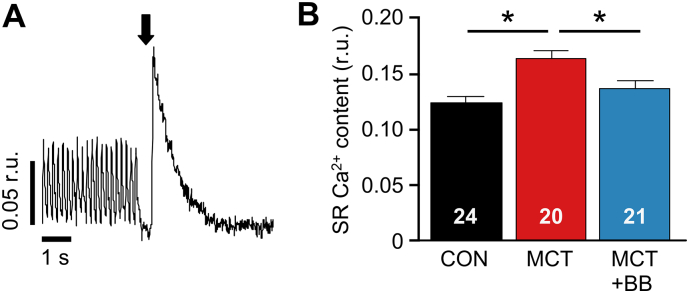
Increased SR load in MCT cells is reversed by BB. A SR Ca2+ content was estimated during steady state pacing at 5 Hz by rapid application of caffeine (indicated by arrow) to deplete SR stores. B SR load was increased in MCT compared to CON, and returned to normal levels by BB. Myocyte numbers given in fig. N = 5–6 rats per group, one way ANOVA. *P < .05.